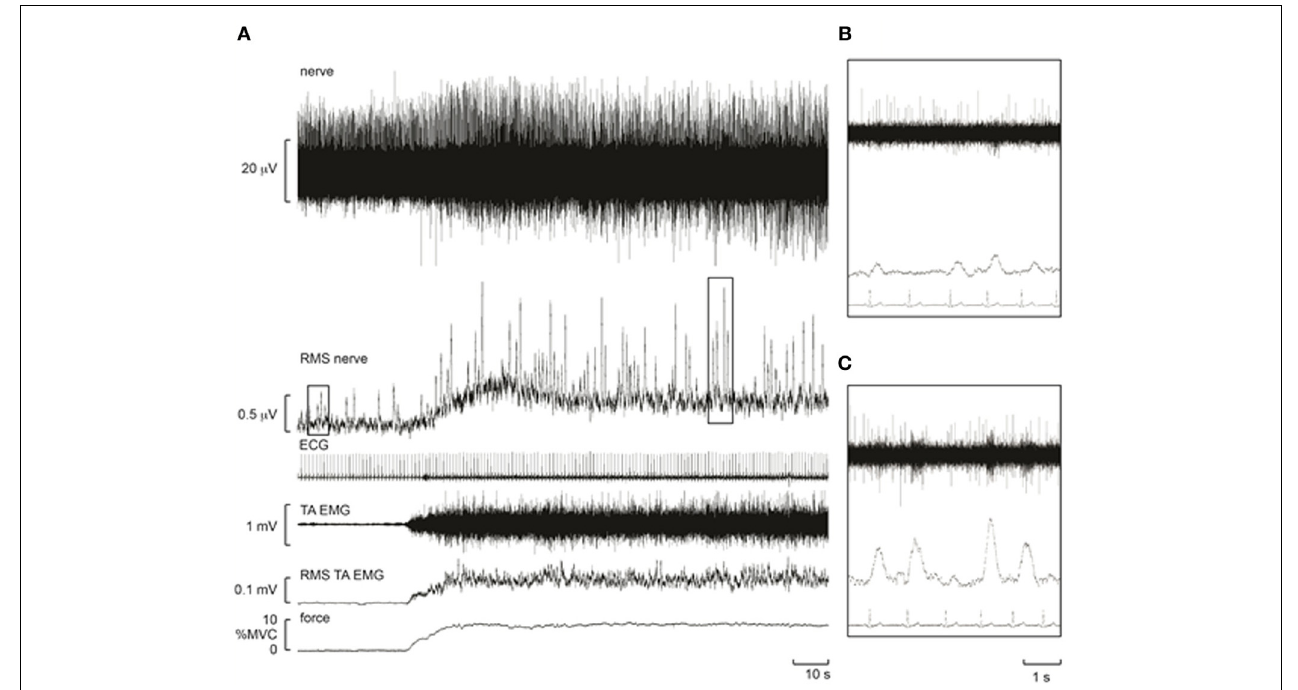
FIGURE 2 | Experimental records from one subject during a control contraction at ∼ 10% MVC. Note that an increase in muscle afferent activity occurs during the contraction, resulting in a baseline shift in the RMS-processed nerve signal. Despite this, bursts of MSNA remained clearly identifiable and increased in amplitude. (A) Raw recordings of the